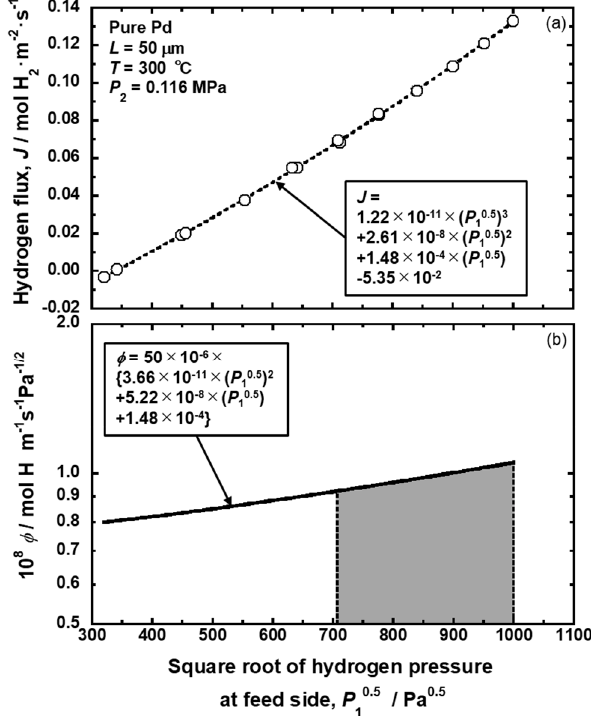
Figure 5. Changes in ( a ) the hydrogen flux and ( b ) the pressure-dependent hydrogen permeation coe ffi cient for pure Pd membrane as a function of the square root of hydrogen pressure at the feed side